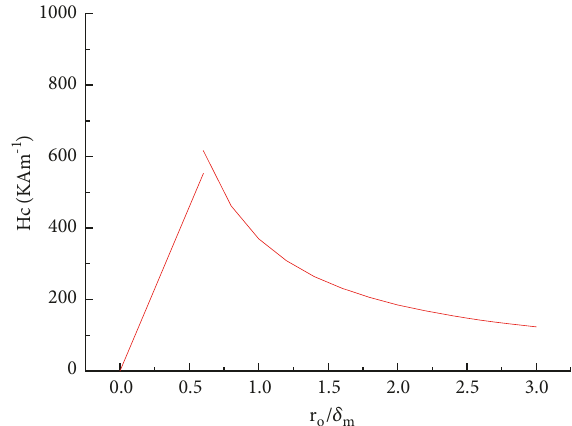
Figure 5: Dependence of coercivity on ratio of r o to 𝛿 m